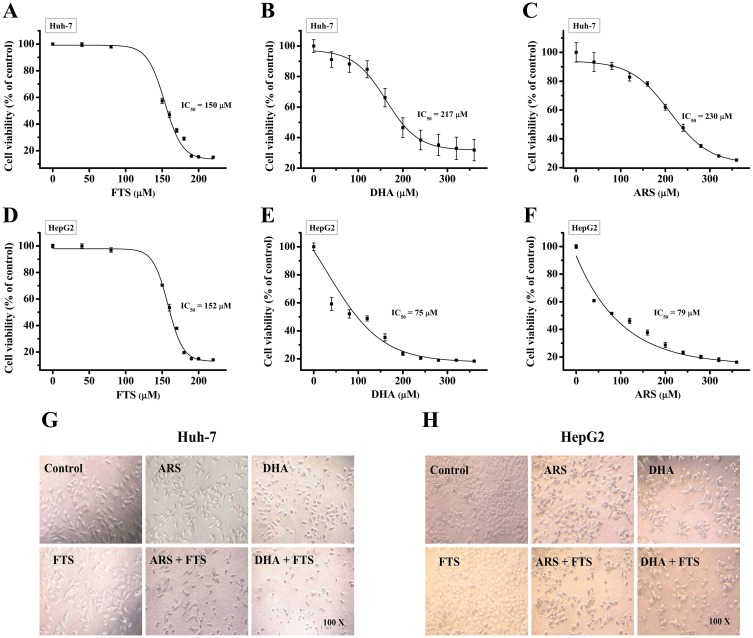
Synergistic cytotoxicity of the combination treatment of DHA/ARS and FTS in HCC cells.(A–F) Dose-response effects of FTS, DHA or ARS alone on Huh-7 cells (A–C) and HepG2 cells (D–F) growth. Cells were treated with increasing doses of FTS, DHA and ARS for 48 h and then analyzed by CCK-8 assay. (G and H) Morphological analysis on the anti-proliferation effect of DHA/ARS in the presence or absence of FTS in Huh-7 cells (G) and HepG2 cells (H). Original magnification: 100×.